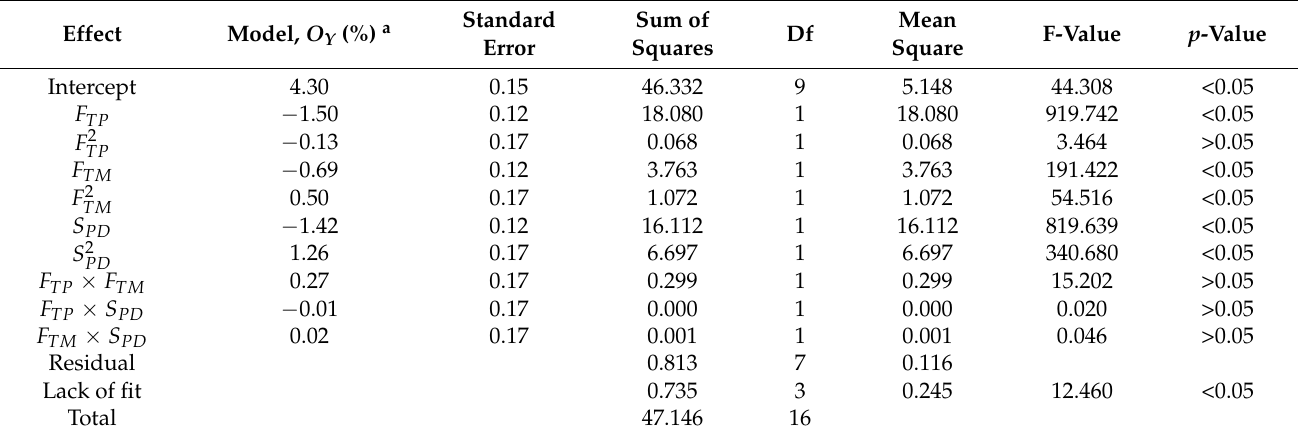
Table 8. Regression analysis of oil yield, O Y (%), under freezing temperatures.